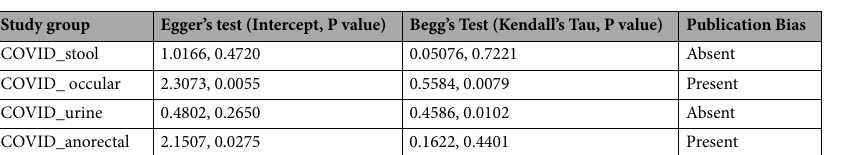
Table 2. Funnel plot and and Egger’s and Begg tests were conducted to assess the publication bias of enclosed literature.